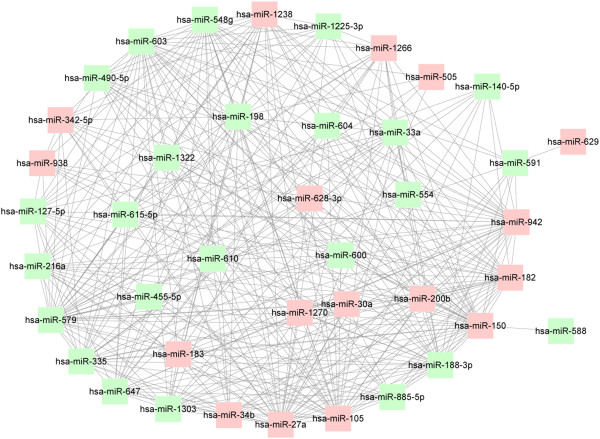
Functional synergistic networks of differentially expressed miRNAs. Red nodes are the up-regulated miRNAs, and the green nodes are the down-regulated miRNAs. Edges represent the synergistic effect between miRNAs.